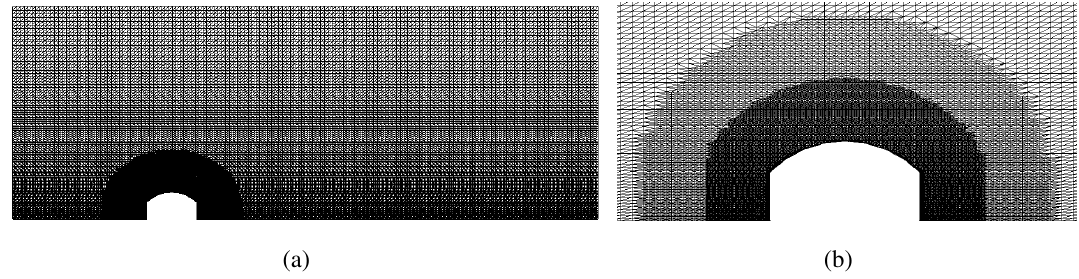
Figure 2. Inlet wind profiles for the validation case: mean streamwise velocity ( U ) ( a ), turbulent kinetic energy ( k ) ( b ) and turbulent dissipation ( ε ) ( c ). The points represent the inlet profiles used in the experiment of Ntinas et al . [24], and the solid lines are the numerical inlets of the simulations.